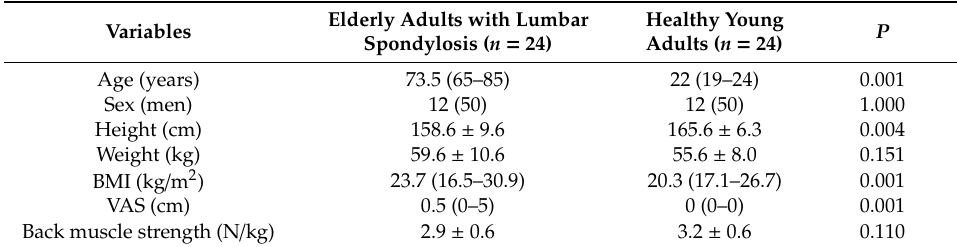
Table 1. Demographic characteristics of the participants.